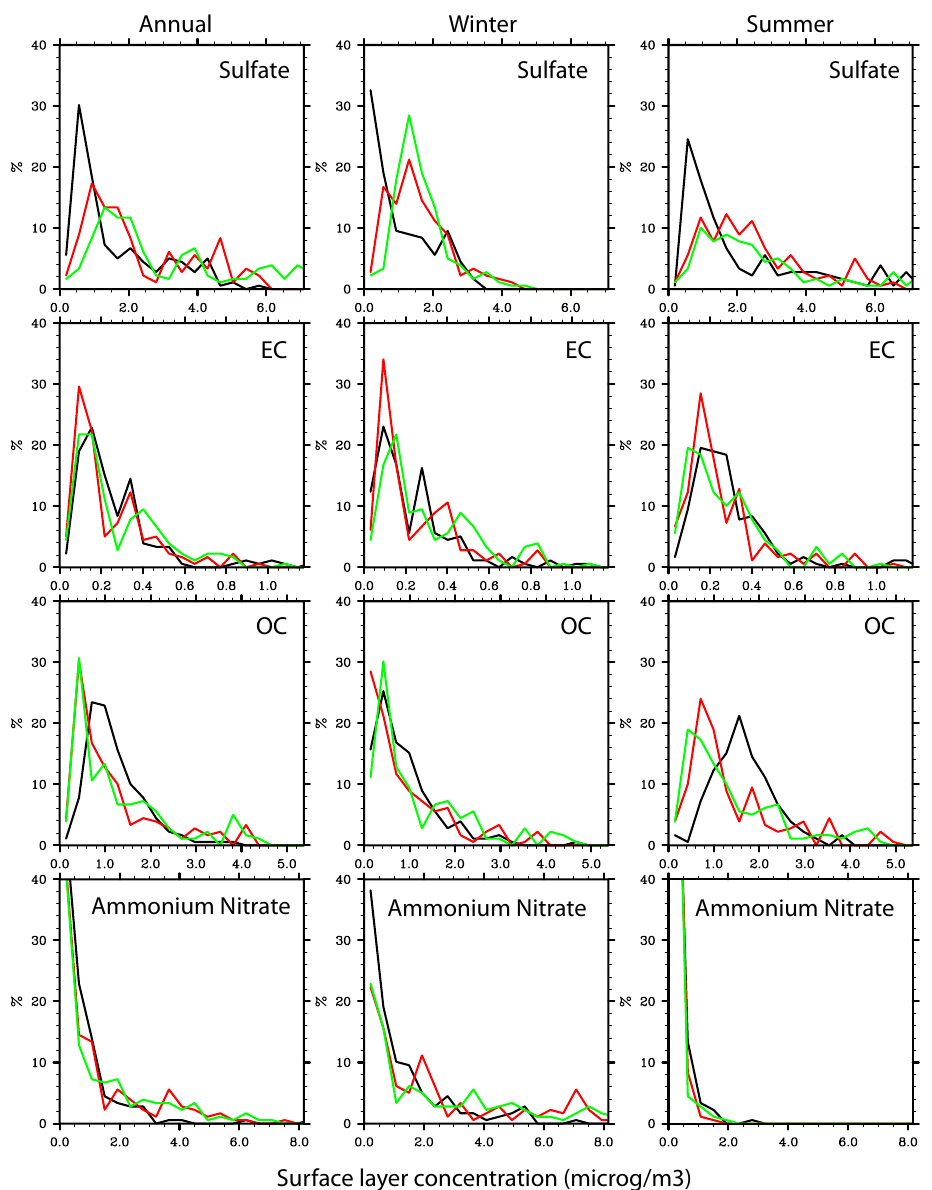
Fig. 17. Probability density function of observed (IMPROVE sites, black line) and modeled (interpolated to observation sites) aerosol surface concentration (sulfate, top row; elemental carbon, second row; organic carbon, third row; ammonium nitrate, bottom row). The simulation results shown here are for the online stratosphere-troposphere (red) and the GEOS5 simulation (green). Analysis is shown for annual (left column), winter (December-January-February, center column) and summer (June-July-August, right column).